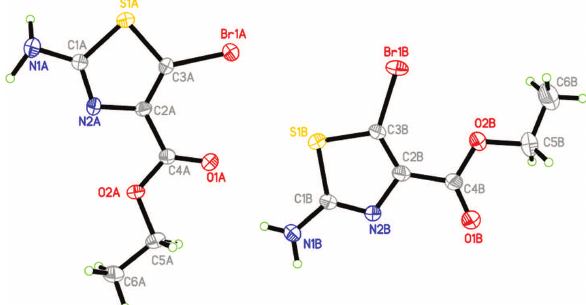
Table 1: Data collection and handling.